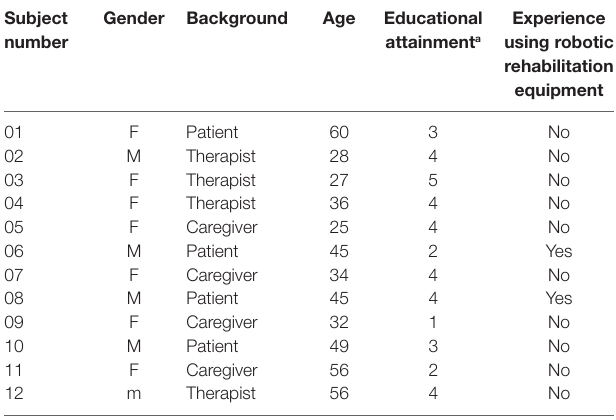
TaBle 3 | Biographical data of the subjects participating the formal test.